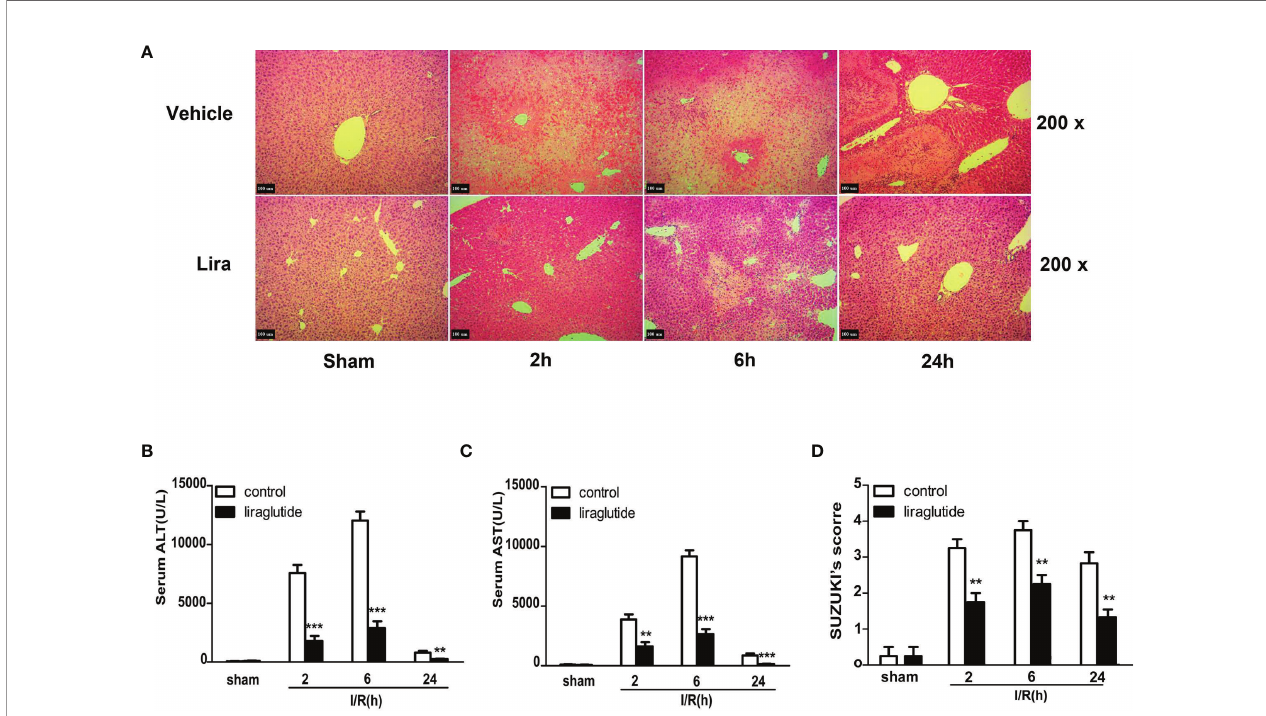
FIGURE 1 | Liraglutide pretreatment ameliorates I/R-induced liver damage. Mice were subjected to 60 min of hepatic ischemia, followed by 2, 6, and 24 h of reperfusion. (A) H&E staining was performed to assess live injury in mice (original magni fi cation 200×). (B, C) Serum ALT and AST levels of the control and liraglutide- treated mice were detected after hepatic IRI (n = 4 – 6 per group). (D) The degree of liver injury was assessed by Suzuki ’ s injury score (n = 3 per group). These results were obtained from at least three independent experiments. Values are presented as mean ± SD. **P < 0.01, ***P < 0.001 vs. the control